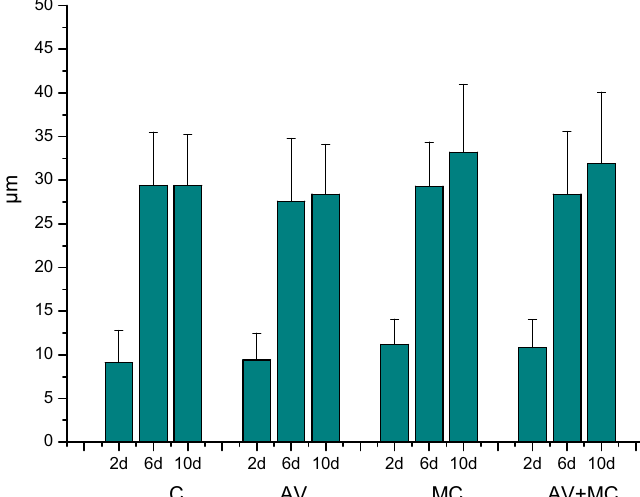
2d 6d FIGURE 6 – Epithelial thickness measurement in the healing area of the skin wound experimentally induced in normal 120-day-old Wistar rats after 2, 6 and 10 days of treatment. C: control; AV: animals topically treated with Aloe vera ; MC: animals treated with microcurrent (10 µA/2 min); AV+MC: animals receiving topical application of Aloe vera plus microcurrent (10 µA/2 min). Values are reported as means ±SD. No statistically significant results are detected